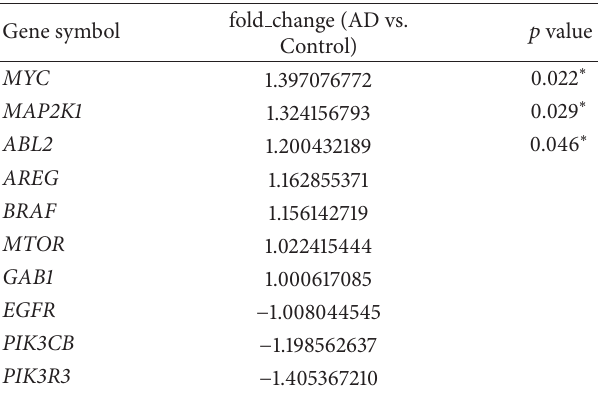
Table 3: Genes of ErbB signaling pathway analyzed in the cDNA